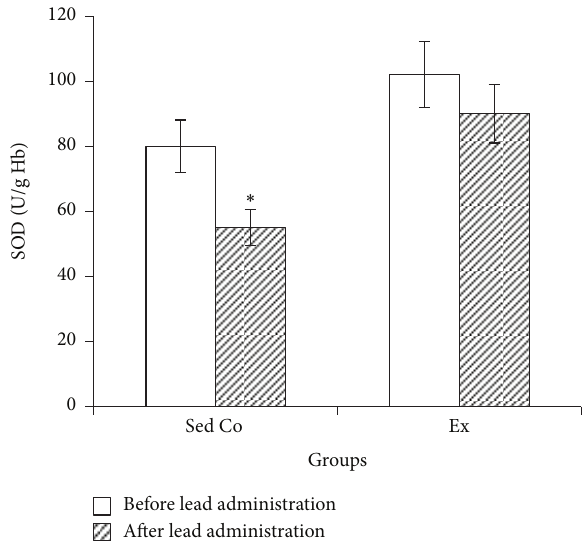
Figure 3: Blood catalase activity in sedentary control and exercise groups before and after lead administrations. Seven days of lead injections (15mg/Kg body weight, ip) to sedentary animals housed in the regular cages caused significant reduction of blood CAT ( ∗ 𝑃 < 0.05 compared to the “before lead administration”); in Ex animals housed in the wheel equipped cages, CAT changes after the same dose lead administrations were not significant. The data are presented as means ± S.E.M. CAT: catalase; Sed Co: sedentary control group; Ex: exercise